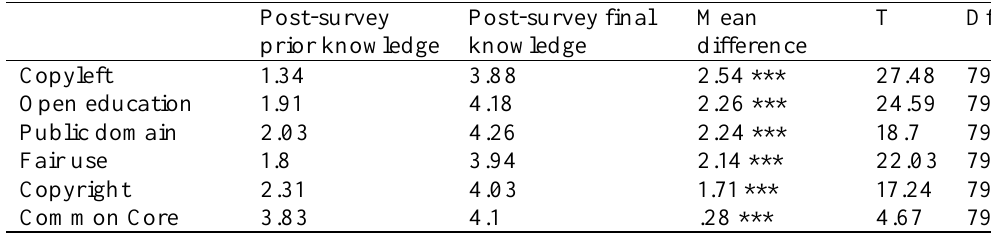
Comparison of Post-Survey Prior Knowledge and Post-Survey Final Knowledge